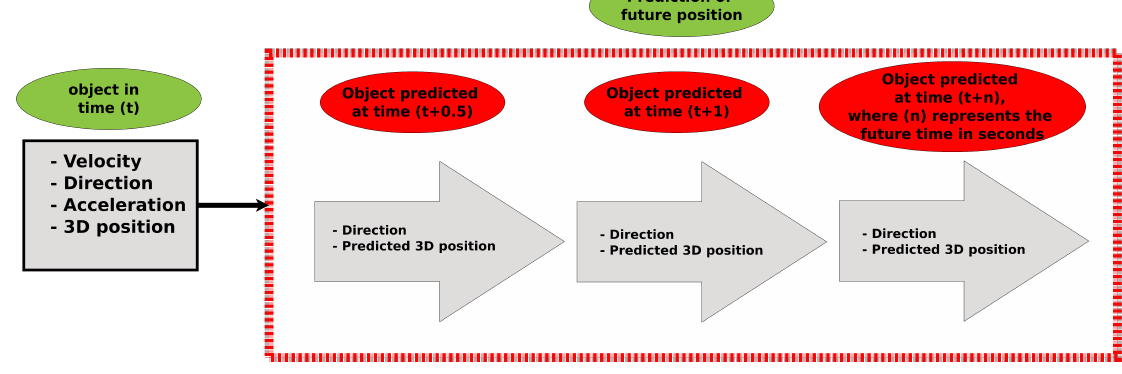
Figure 7. Diagram of the anticipation